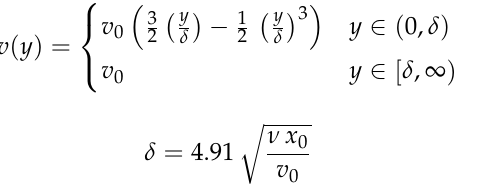
Figure 11. ( a ) The flow velocity profile v ( y ) (blue) is qualitatively shown for v 0 = 60 m deformed shapes for v 0 = ˜ v m , ˜ v ∈ { 0,10,20,40,60 } . Change of the support reactions ( b ) F x and ( c ) s M z in dependence on the flow velocity v 0 . ( d ) The drag force Q D along the arclength s of the sensor shaft for v 0 according to ( a ) excluding v 0 = 0 m . ( e ) The projected obstruction area A ⊥ for different v 0 s